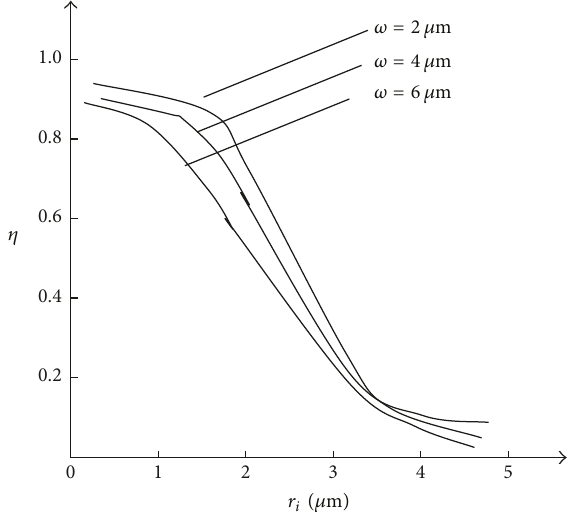
Figure 2: The relationship between the coupling efficiency and the lateral deviation 𝑟 𝑖